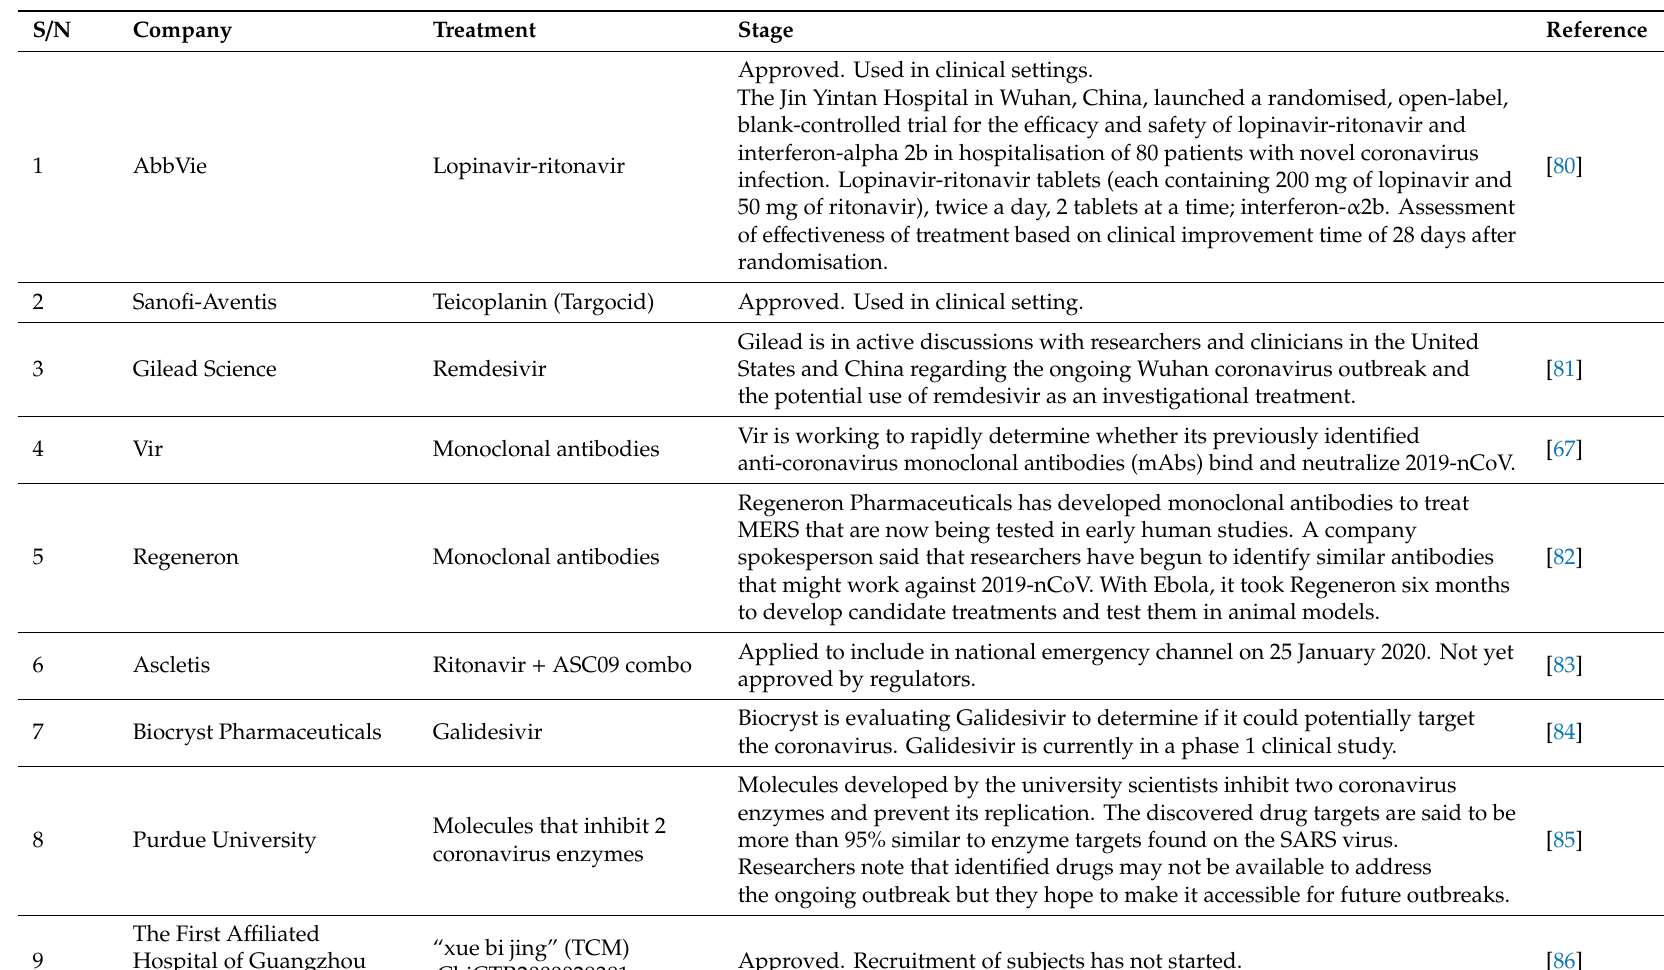
Table 5. Potential & ongoing therapeutics trials of 2019-nCoV